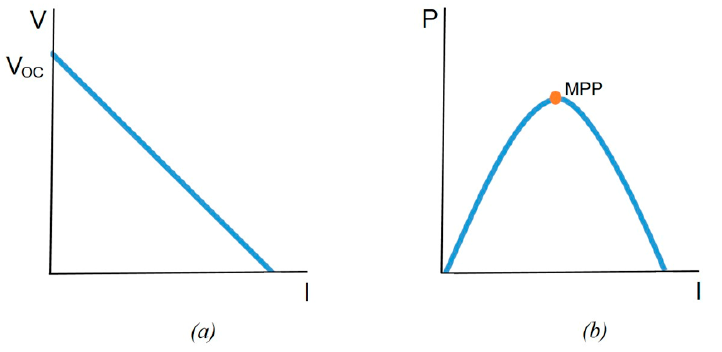
Figure 3. TEG characteristic curves ( a ) V–I curve ( b ) P–I curve.